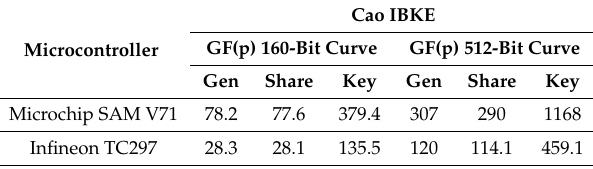
Table 3. Computational overhead in milliseconds for Cao’s pairing-free